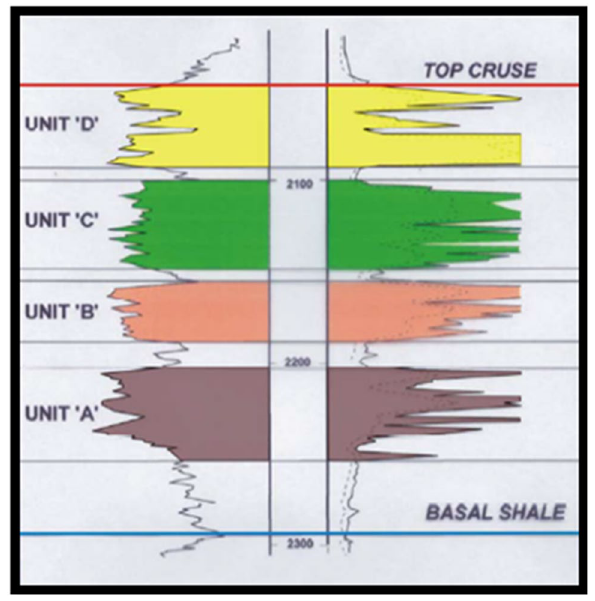
Fig. 2 Cruse ‘E’ type log - CRUSE 166 (adapted from V. Ramlal